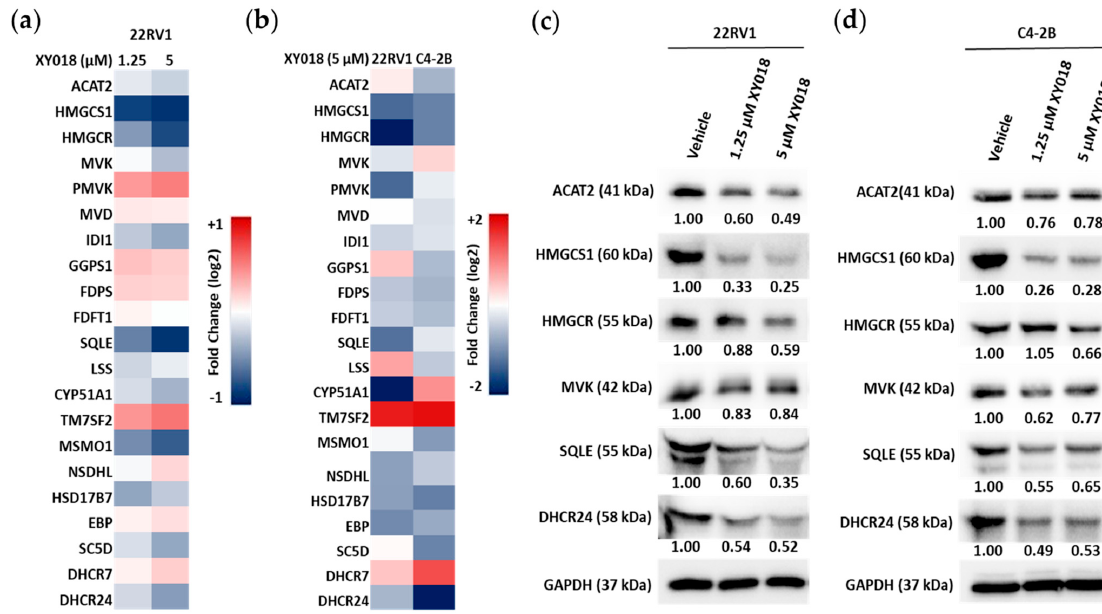
Figure 2. ROR γ antagonists inhibit key cholesterol biosynthesis gene expression in mCRPC